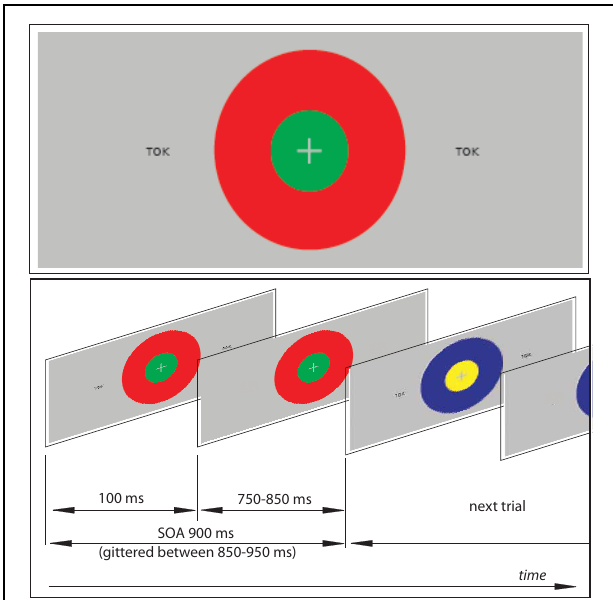
FIGURE 1 | An example of the visual stimulation employed and a schematic demonstration of the visual sequence. The subjects’ task was to focus on the center of the screen to detect combinations of two concentric circles, which were present continuously but changed colors pseudorandomly at every SOA refresh. At the same time, unattended orthographic stimuli were presented briefly (100ms) at symmetrical locations on visual periphery (at 2.5 ◦ angle from the center to the left and to the right) in oddball sequences containing frequent standard and rare unexpected deviant stimuli (see also Table 1 ). In addition to the set of oddball blocks, a sensory visual baseline condition was included that only contained concentric circles but no orthogprahic stimuli on the